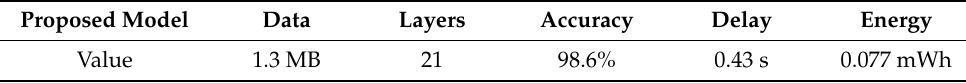
Table 7. Energy consumption and delay of the proposed method.